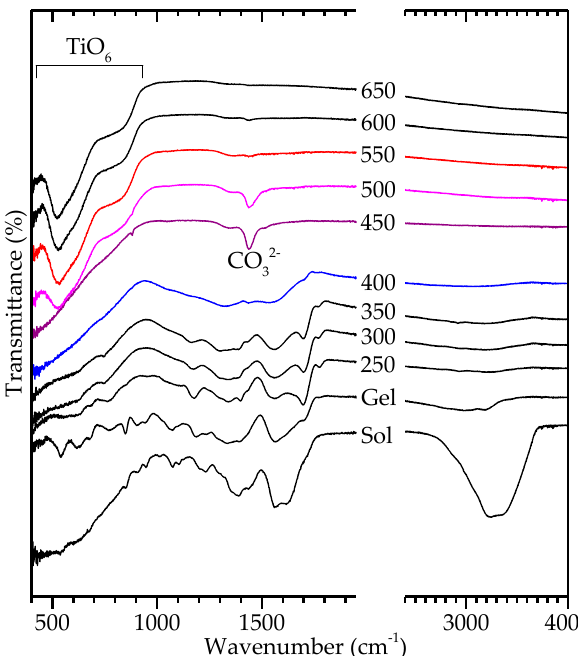
Figure 5. Fourier transform infrared (FTIR) spectra of calcined citrate BNT powders. The scale is changed at wavenumber 2000 cm –1 in order to more clearly show the features of interest. Consecutive graphs are offset the same value.